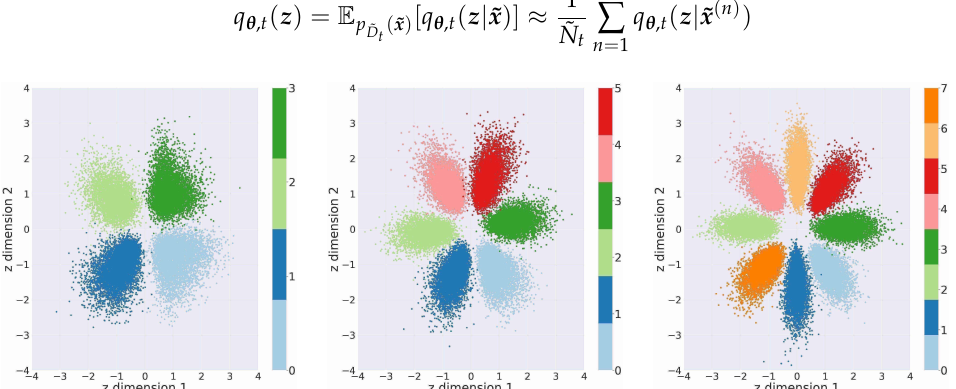
Figure 2. 2-D latent space aggregate posterior visualization for continually learned MNIST (Modified National Institute of Standards and Technology database). From left to right, the latent space for four, six and then eight classes are shown. This is best viewed in